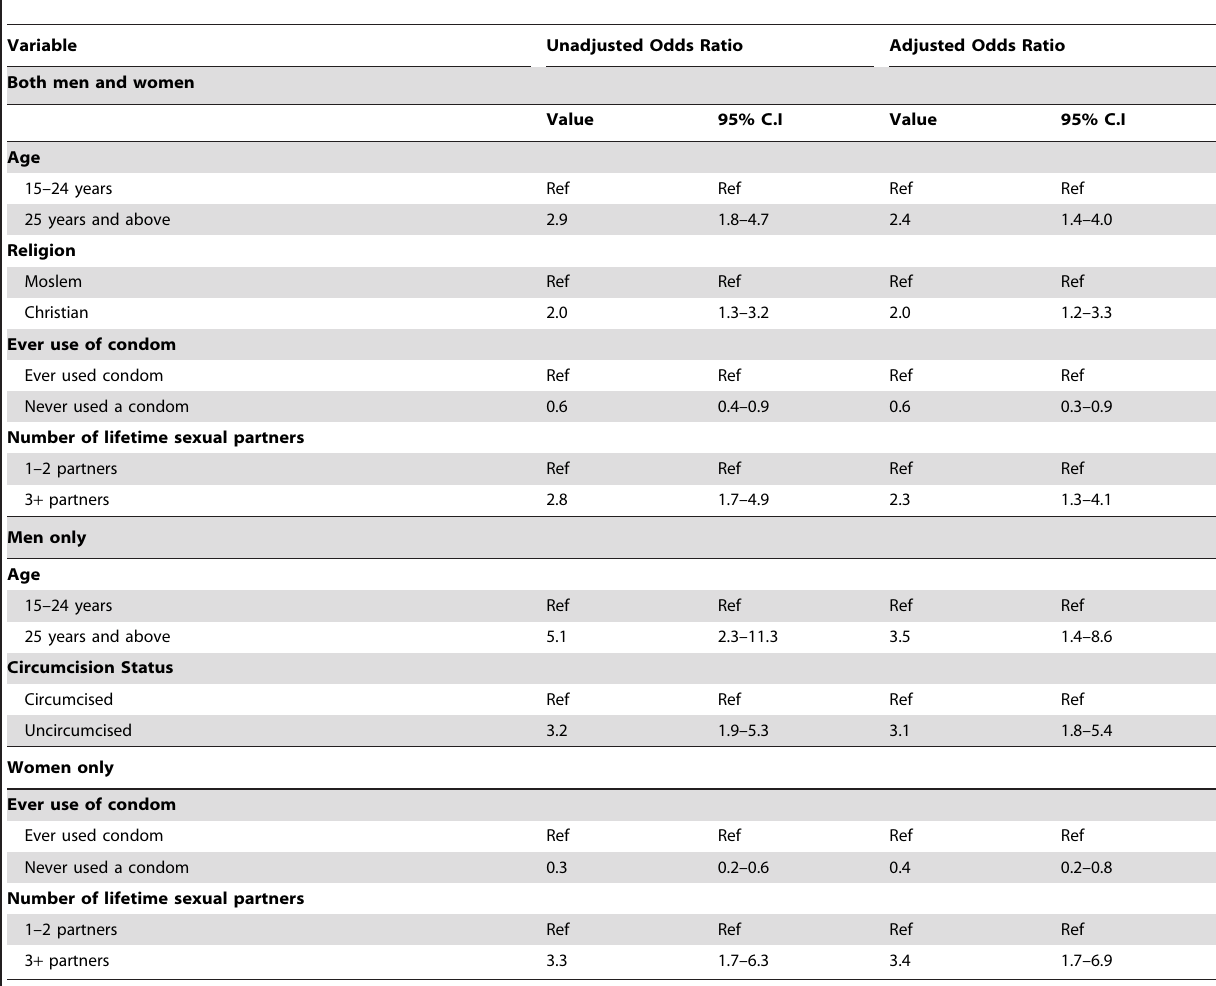
Table 5. Risk factors for HIV infection in fishing communities (Multivariate analysis).